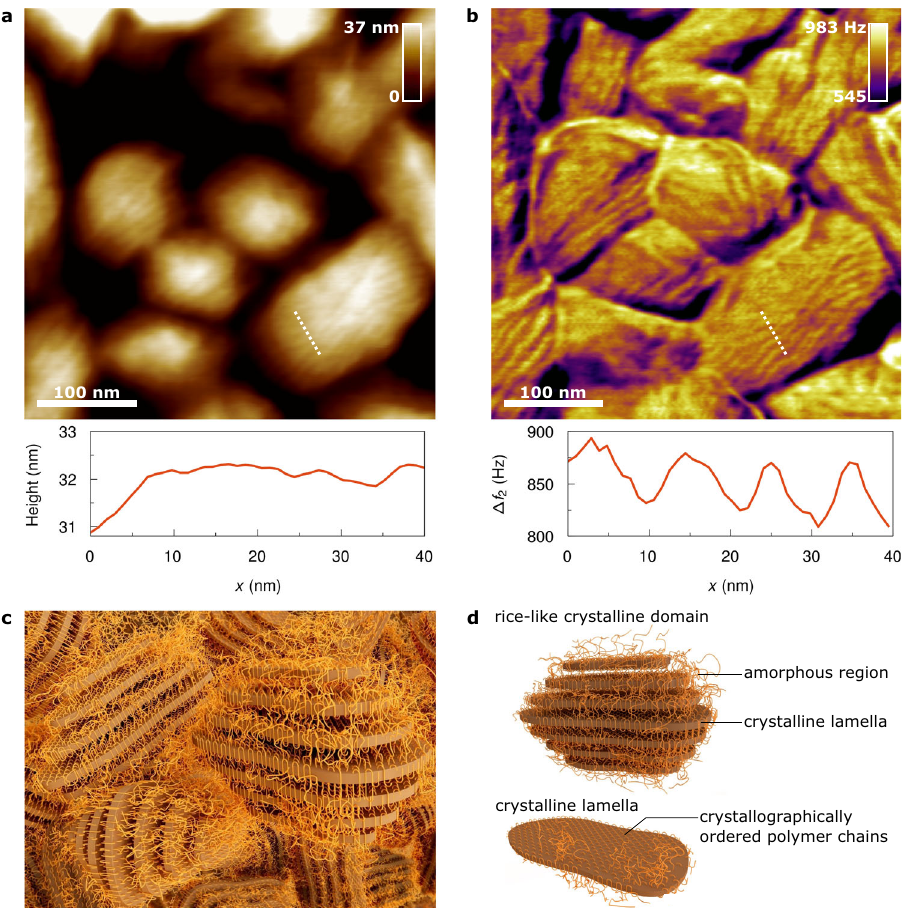
Fig. 1 Nano- and microstructure of the semi-crystalline polymer P(VDF-TrFE). a , b High-resolution bimodal AFM images of P(VDF-TrFE), showing the true topography (height) and the frequency shift of the second mode ( Δ f 2 ). The pro fi le of a cross-section through the lamellar structure of the crystalline domains is shown under each image, respectively. The bimodal AFM measurements displayed were performed at 300 K. c 3D illustration of the morphology of the semi-crystalline polymer P(VDF-TrFE), showing the ‘ intermixture ’ of crystalline and amorphous regions. d 3D illustration of a rice-like crystalline domain and a crystallographically ordered lamella of